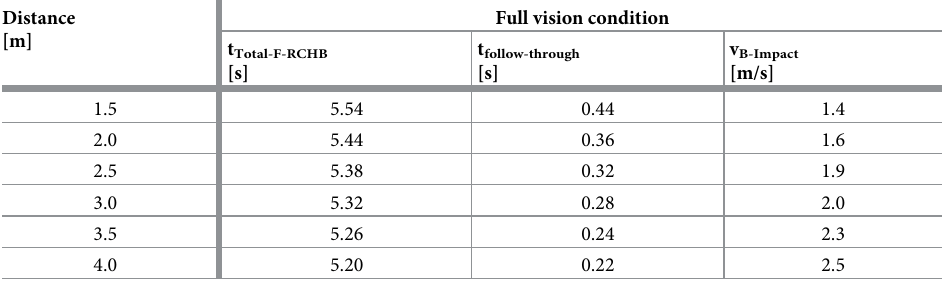
Table 4. Temporal and kinematic differences between the 6 putting distances under full vision condition only.